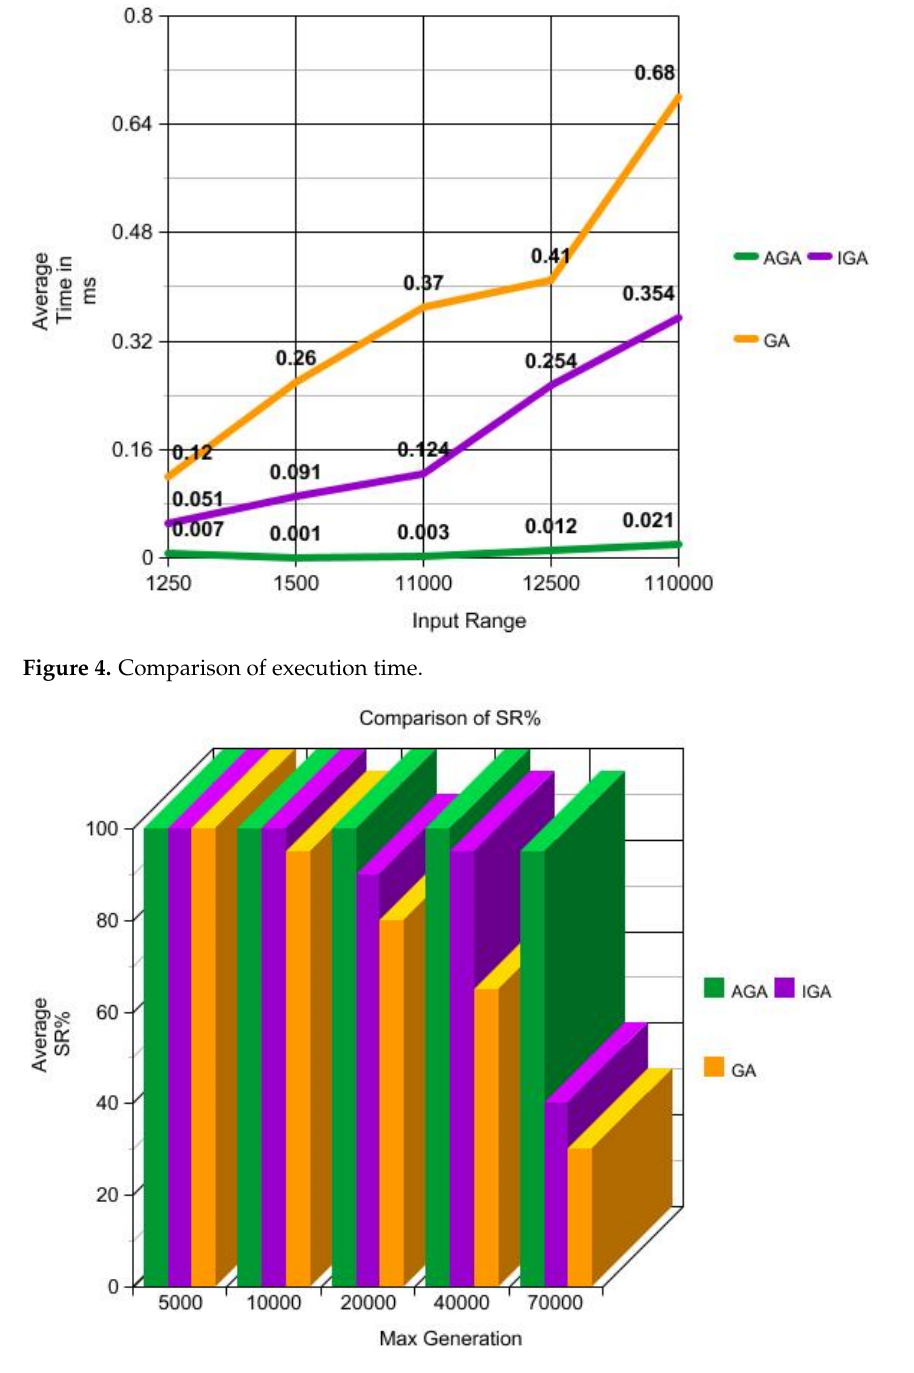
Figure 5. Comparison of success rate.